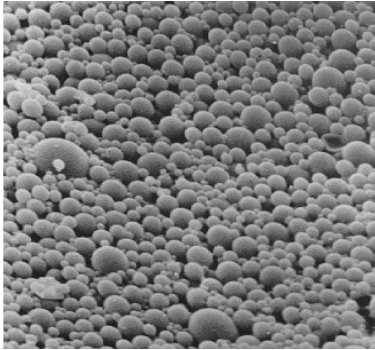
Fig. 2: A suspension of paraffin microcapsules used as a media.